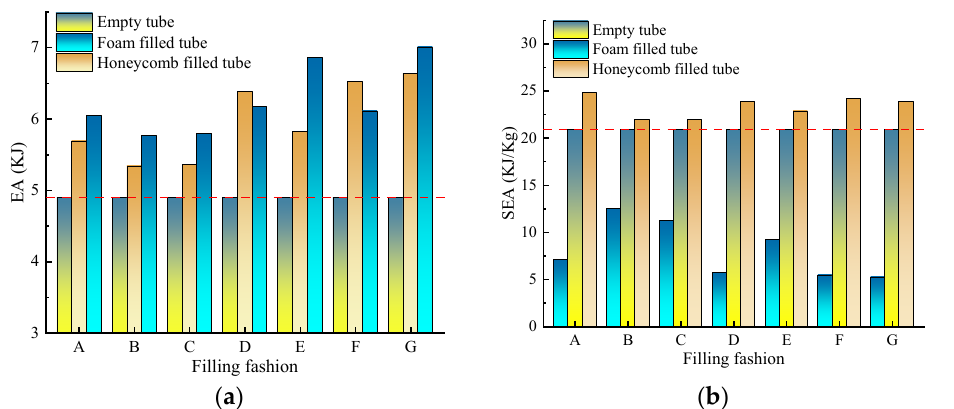
Figure 5. EA and SEA of the filling structure under different filling styles. ( a ) EA of filling structure. ( b ) SEA of filling structure.